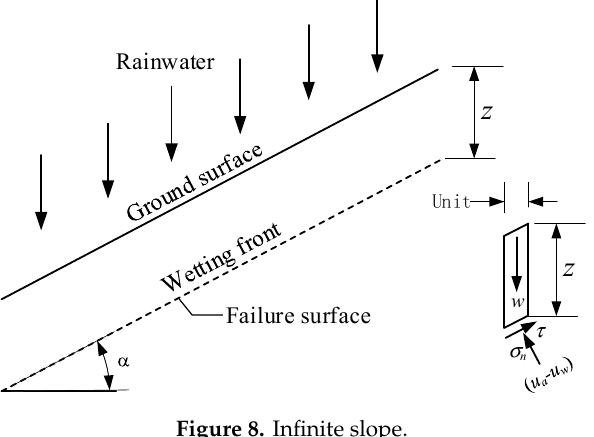
Figure 8. Infinite Figure 8. Infinite slope.